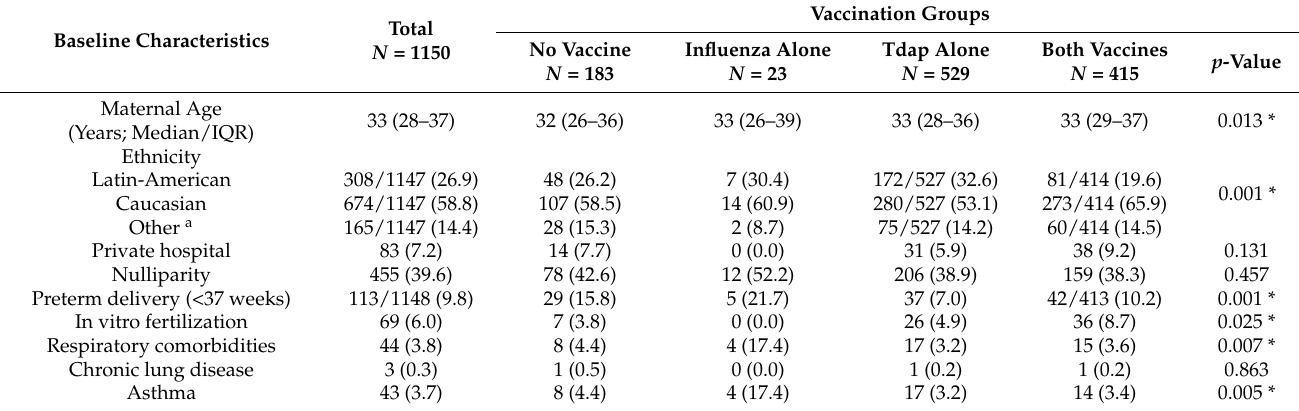
Table 1. Baseline characteristics of the study participants and by vaccination group.